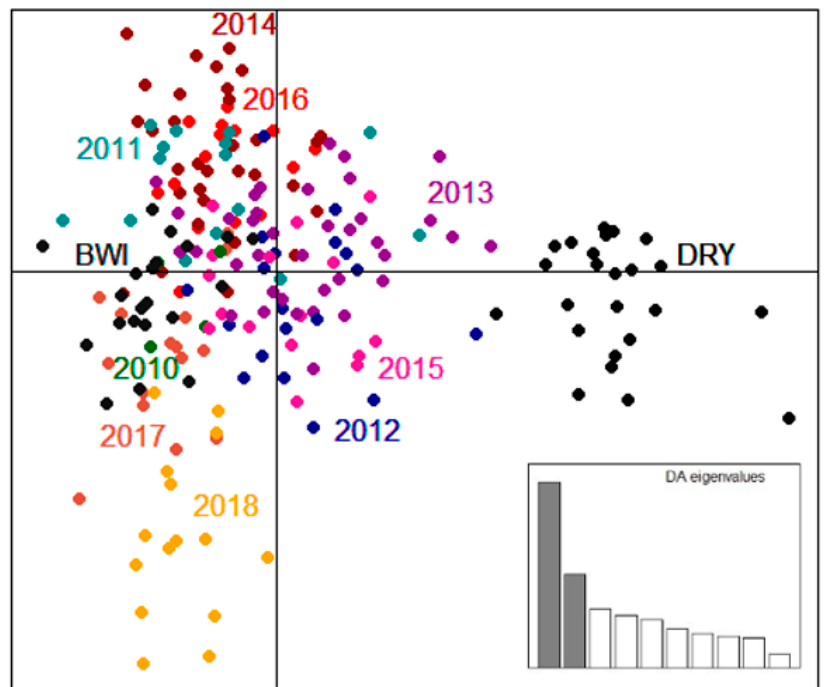
Figure 2. Discriminant Analysis of Principal Components (DAPC) of Bettongia lesueur illustrating the relationship between the founding groups, Barrow Island (BWI: dark grey) and Dryandra (DRY: black) and the Matuwa translocated population between 2010 and 2018 based on retaining 90% of cumulative variance. Each dot represents an individual colored by population. The inset shows the histogram of discriminant analysis eigenvalues.